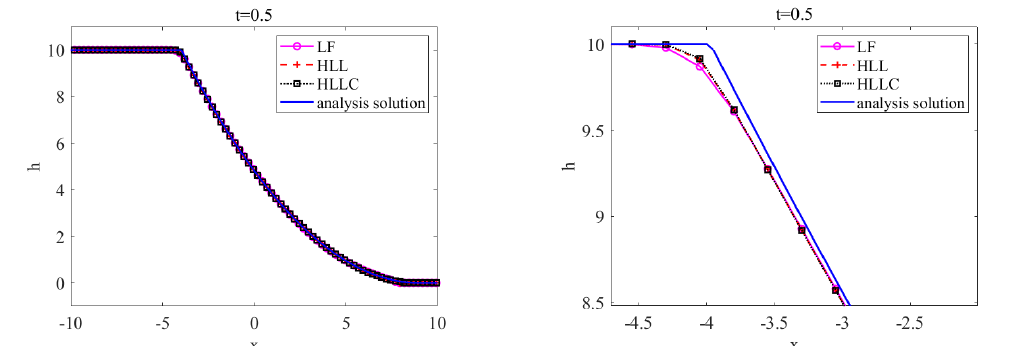
Figure 4. Analytical solution and numerical solutions with WENO–LF, WENO–HLL, and WENO– HLLC for the 1D dam break problem at t = 0.5. The solutions of h on the whole domain ( left ); the solutions of h in the range x ∈ [ − 4.5, − 3 ] ( right ).